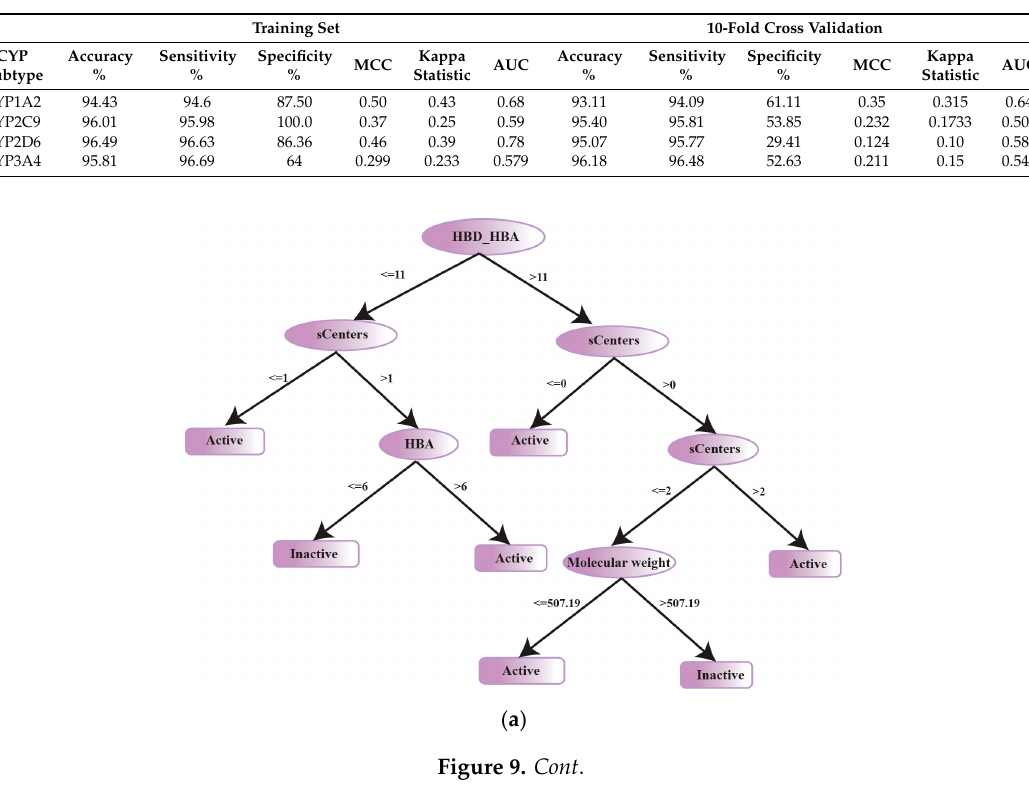
Table 4. The model evaluation parameters for the inhibitor-based decision tree classifiers of CYP1A2, CYP2C9, CYP2C19, CYP2D6 and CYP3A4. MCC: Matthews correlation coefficient; AUC: Area under the curve.